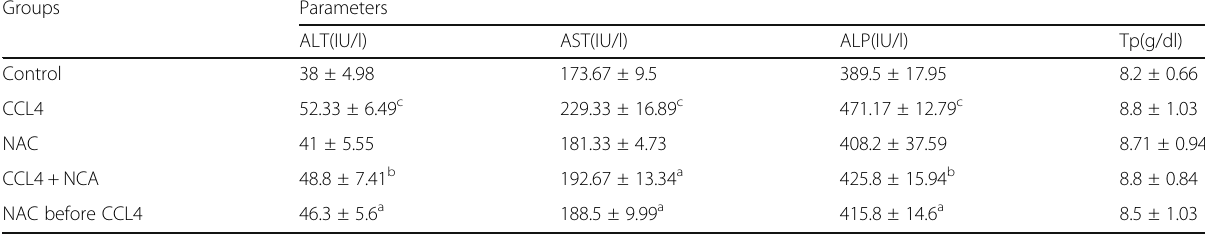
Table 1 Assessment of serum parameters in all groups Groups